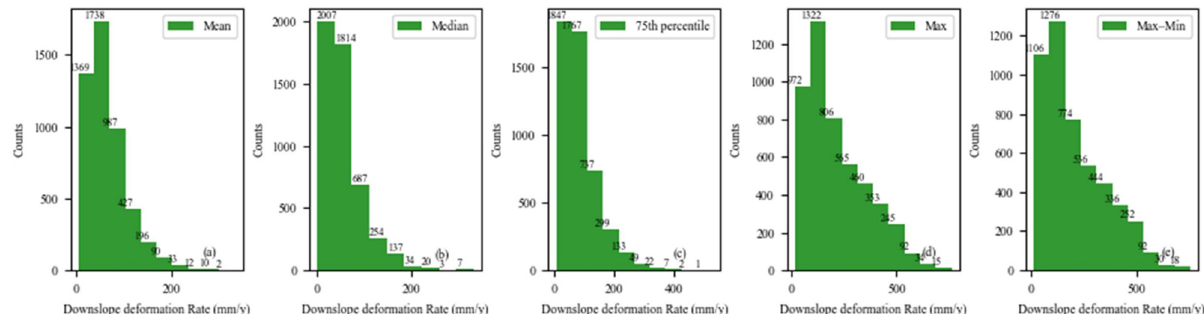
Figure 14. The distribution statistics of rock glacier downslope deformation characteristics. ( a – e ) Mean, median, 75th per- centile, maximum, and difference between the maximum and minimum downslope deformation rate.